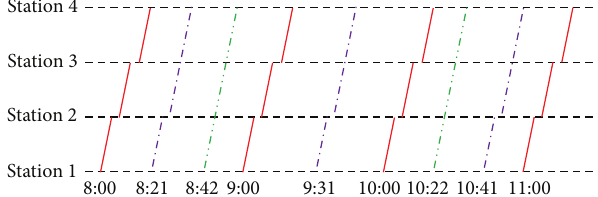
Figure 2: A simple example of multiperiod mixed train